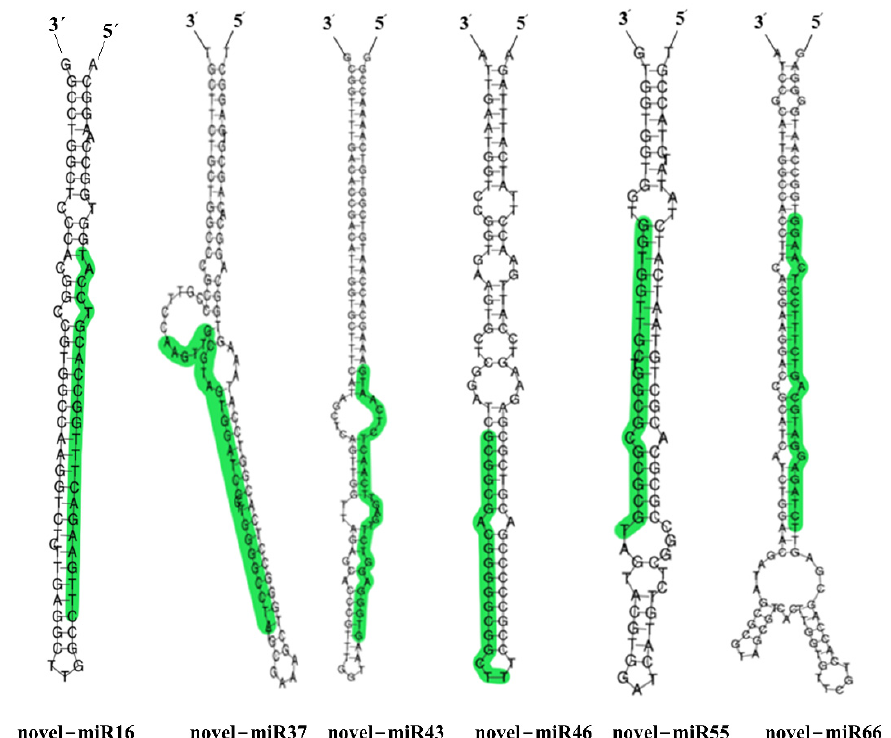
Figure 4. Predicted secondary structure of six novel precursor miRNAs differently expressed in Suntop and Sunmate in response to salinity stress. Green shading indicates the sequence of the mature miRNAs.